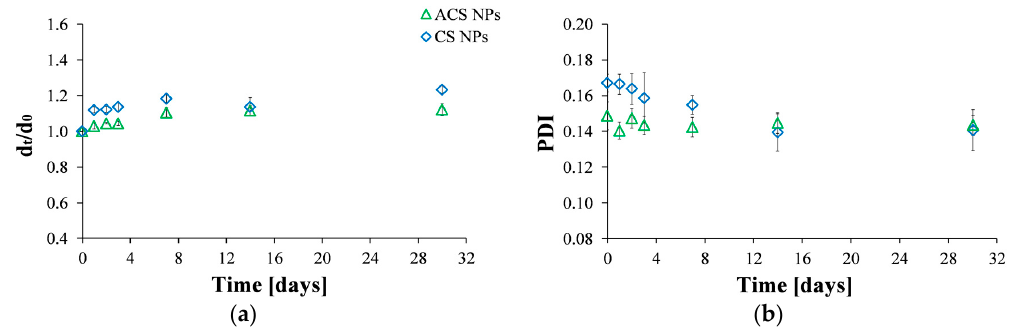
Figure 2. Size stability over time measured by: ( a ) Hydrodynamic diameter by intensity at time t divided by the initial diameter at time zero; ( b ) PDI values of ACS (green triangle) and CS (blue diamond) nanoparticles fabricated at an 8:1 mass ratio of polymer to crosslinker.